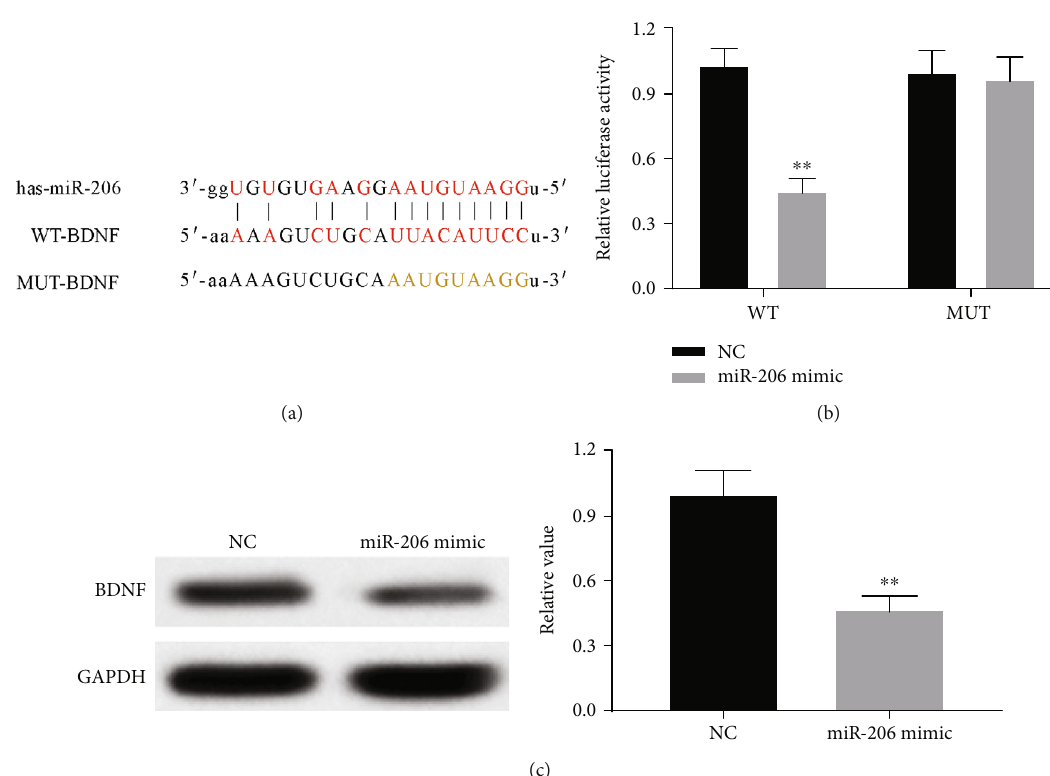
Figure 3: miR-206 targeted downregulation of BDNF. (a) The bioinformatics analysis result showed that BDNF was a target gene of miR-206. (b) The dual-luciferase reporter gene assay was used to verify the relationship between miR-206 and BDNF. (c) Western blotting was applied to measure the expression of BDNF. ∗∗ p < 0 : 01 vs. the NC